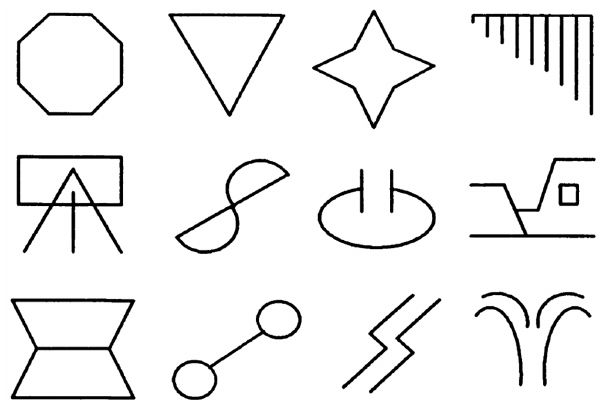
Figure 2. Abstract figures used in the experiment to create novel